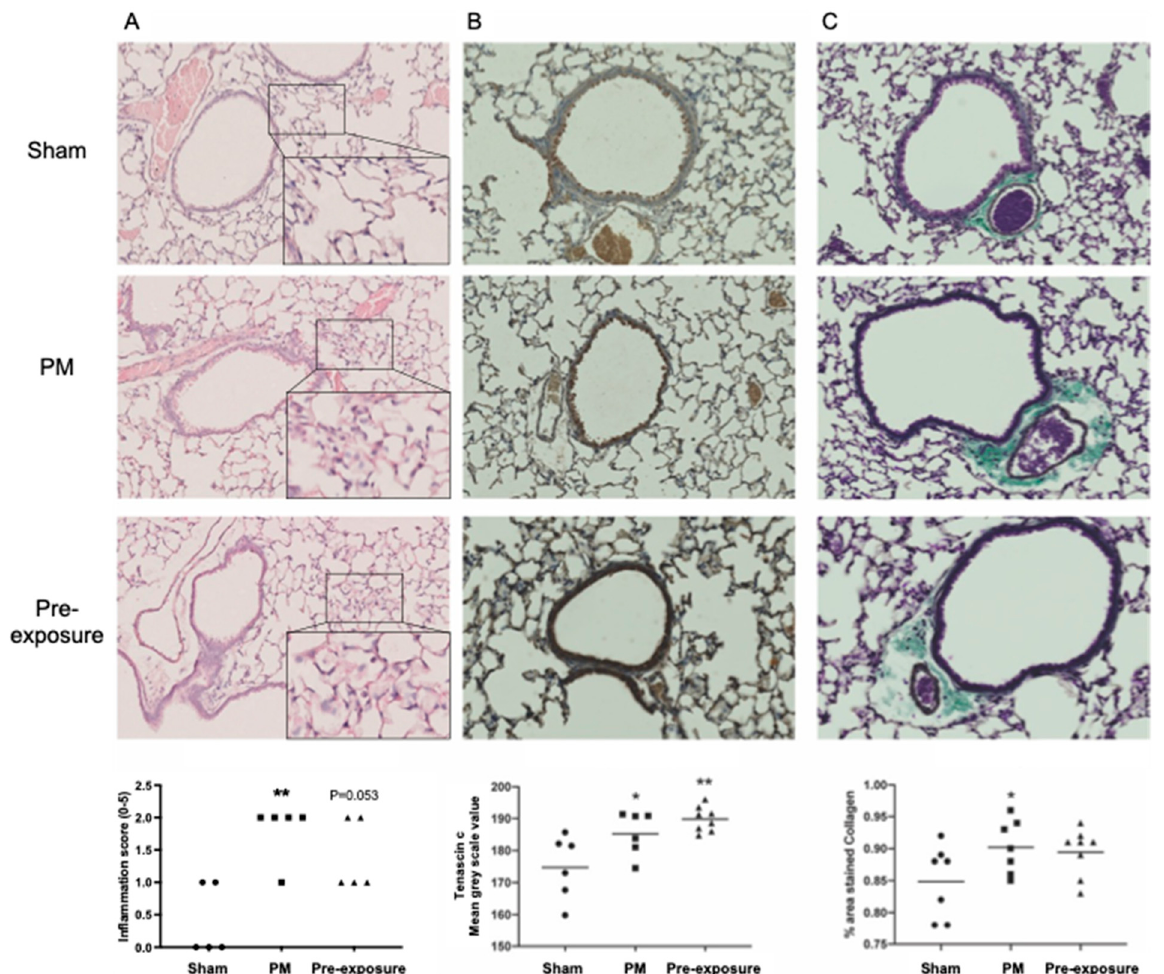
Figure 1. TNC is increased during early life lung development. Mean expression of TNC at different developmental stages (neonates (up to 30 days), infant (>30 days and < 1 year), child (> = 1 year and < 10 years), and adult (>20 years)) in endothelial cells, epithelial cells, immune cells, mesenchymal cells (defined as CD140+ matrix fibroblasts, myofibroblast/smooth muscle, pericyte, proliferative mesenchymal progenitor, and intermediate fibroblasts), presort stained mixed control and biopsy samples. Data generated from https://research.cchmc.org/pbge/lunggens/mainportal.html (ac- cessed on 1 Novmber 2022) CPM: count per million reads mapped.